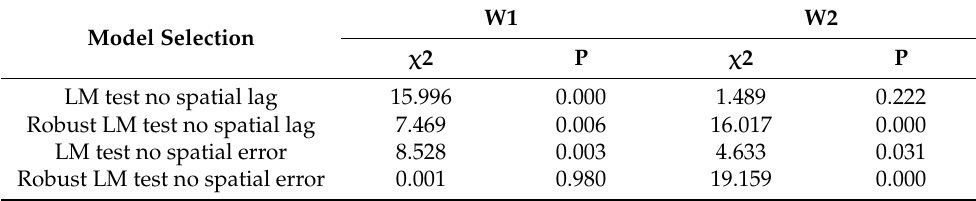
Table 4. The selection and definition of